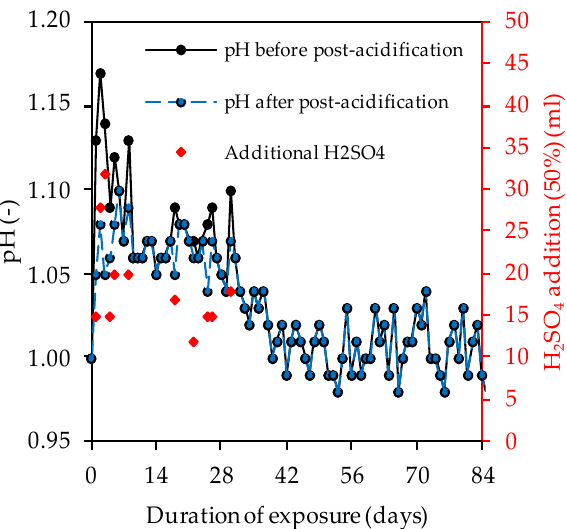
Figure 8. pH of sulfuric acid solution over the course of exposure and volume of additional H 2 SO 4 . Figure 9 contains the element concentration (mg/L) of potassium, aluminum and